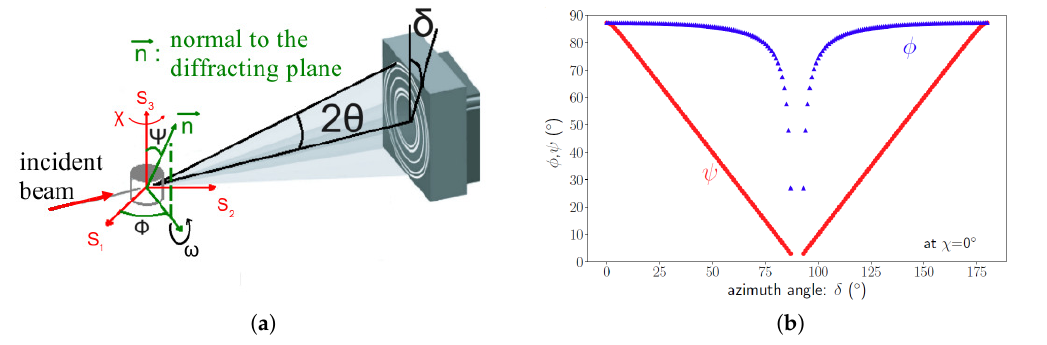
Figure 4. ( a ) Angles definition from setup configuration: (S1, S2, S3) is the sample reference system and ( b ) evolution of ( Φ , Ψ ) defining the direction normal to the diffracting plane